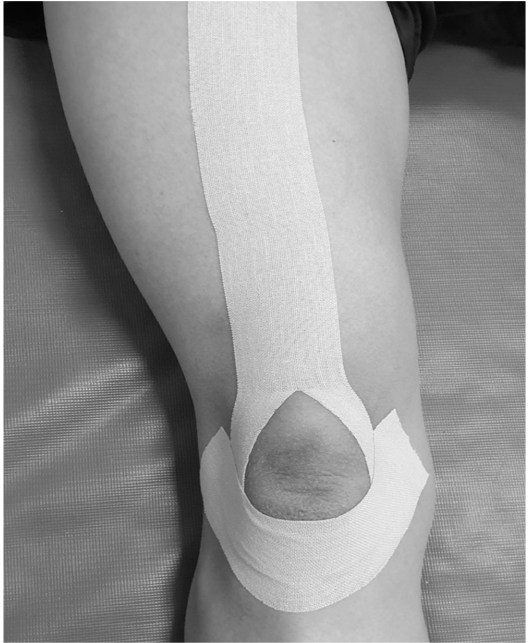
Figure 2. Kinesio taping technique.